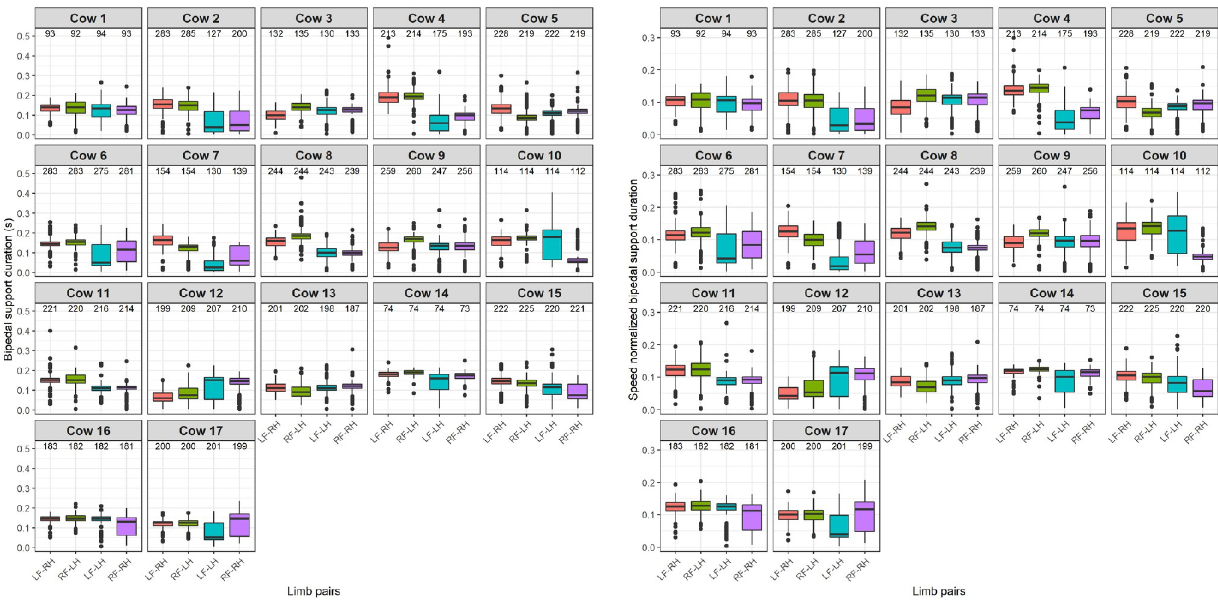
Fig 4. Distributions of bipedal support durations (left panel) and speed normalized bipedal support durations (right panel) for every cow and limb pairs separately. In red: LF-RH, green: RF-LH, blue: LF-LH and purple: RF-RH. The number of selected strides per limb is shown above the boxes. The spacing of the boxplot shows the range between the first and third quartile, the median is indicated with the black line, the whiskers show the range of the maxima and minima and the outliers are indicated with dots.